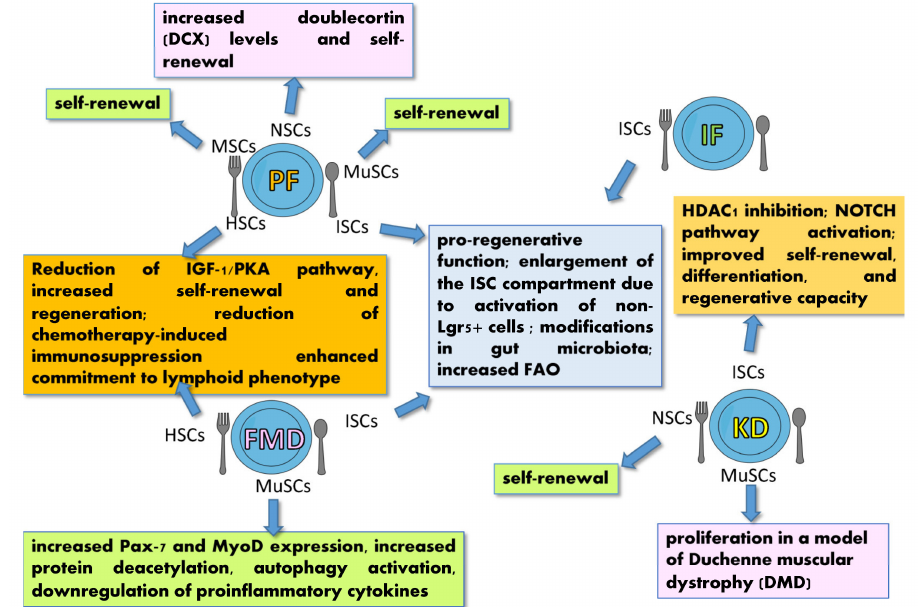
Figure 5. Effects of PF, IF, FMD and KD on adult SCs. Abbreviations: FAO: fatty acid oxidation; HDAC1: histone deacetylase 1; HSCs: hematopoietic stem cells; IGF-1: insulin-like growth factor 1; ISCs: intestinal stem cells; MuSCs: muscle stem cells; NSCs: neural stem cells; PKA: protein kinase